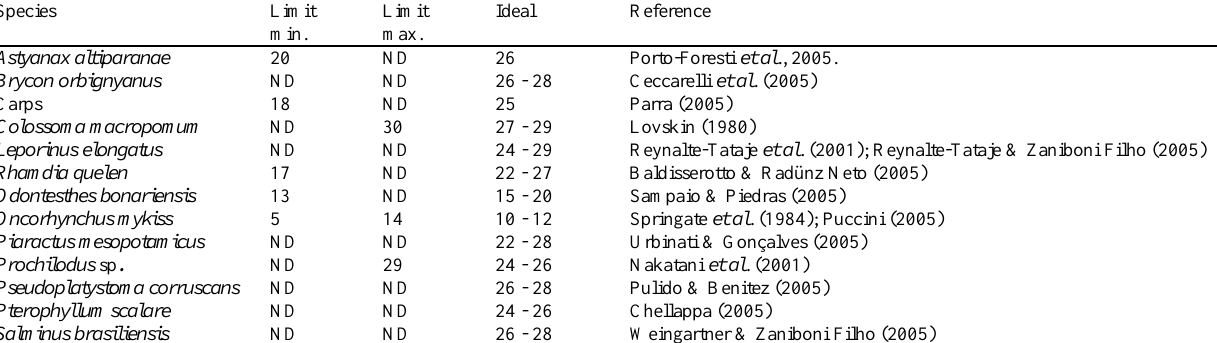
Table 2. Maximum, minimum and ideal temperature range (ºC) for reproduction and egg incubation for different fish species. ND – Not determined. Species Limit Limit min.